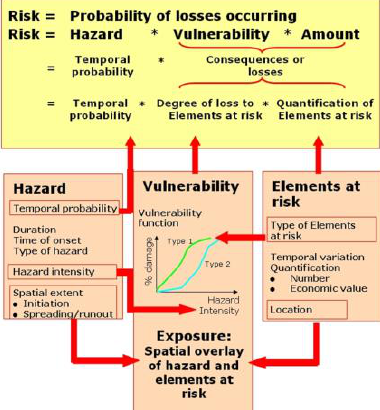
Figure 3. Specific methodology of generating the exposure